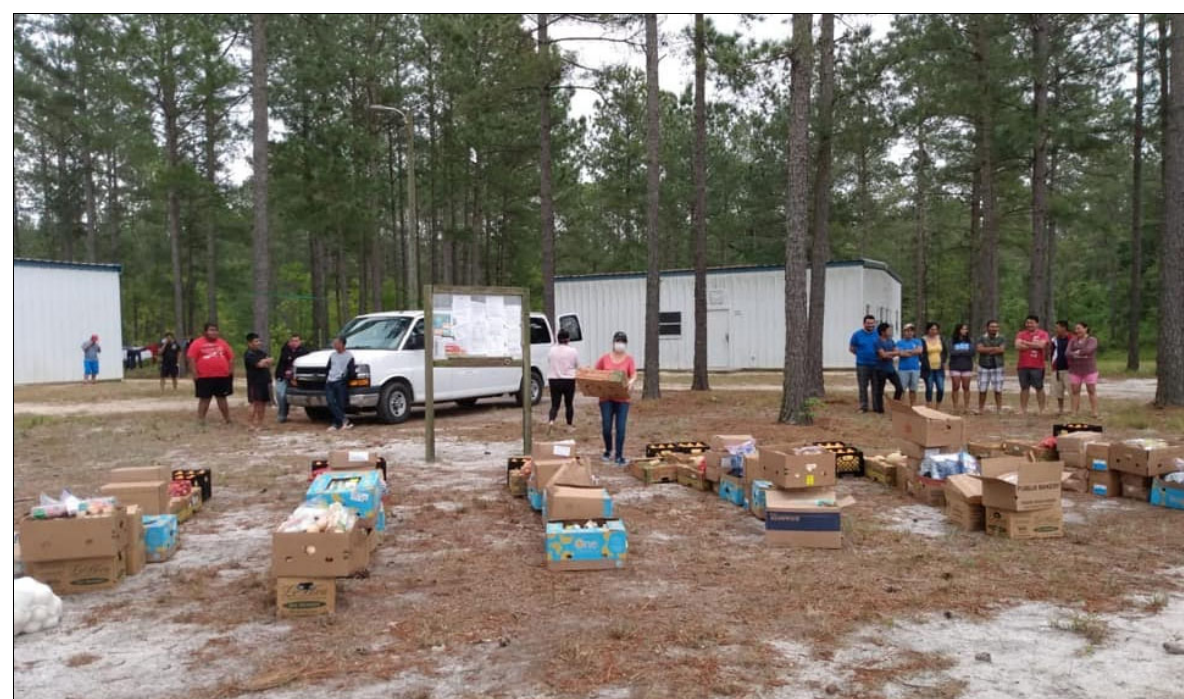
Figure 3. Food Distribution to Farmworkers